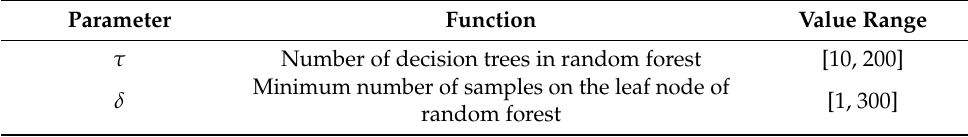
Table 1. Tuning parameters adjusted for